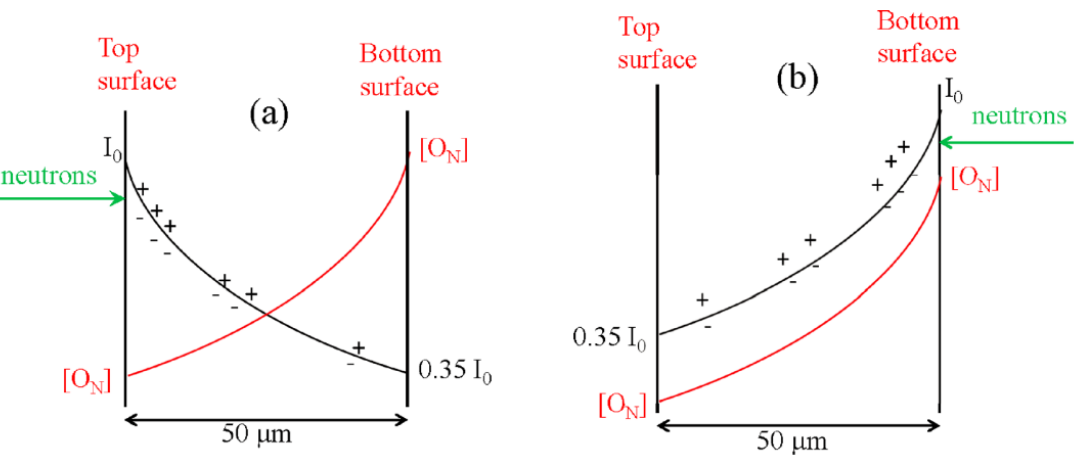
Figure 7. Schematic of oxygen occupancy in nitrogen sites with neutron incidence direction ( a ) from top surface, ( b ) from bottom surface [The figure is reproduced from [76] copyright 2018 with permission from AIP Publishing].